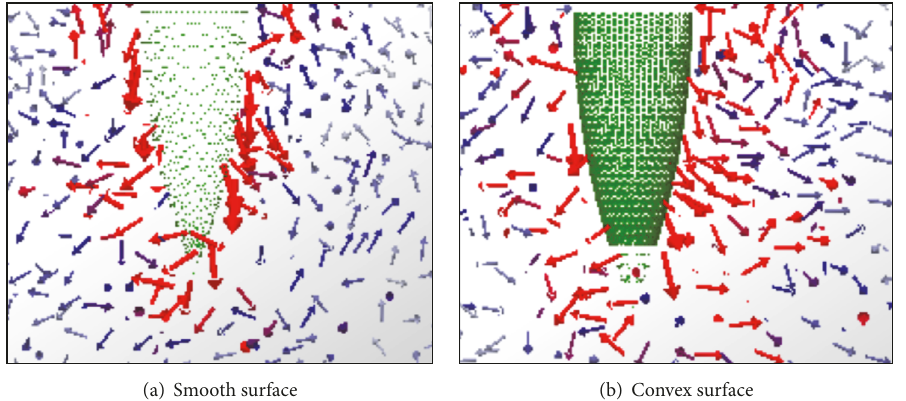
Figure 12: Comparison of the velocity of broken particles around the projectile nose at 0.4 ms: (a) smooth surface and (b) convex surface.